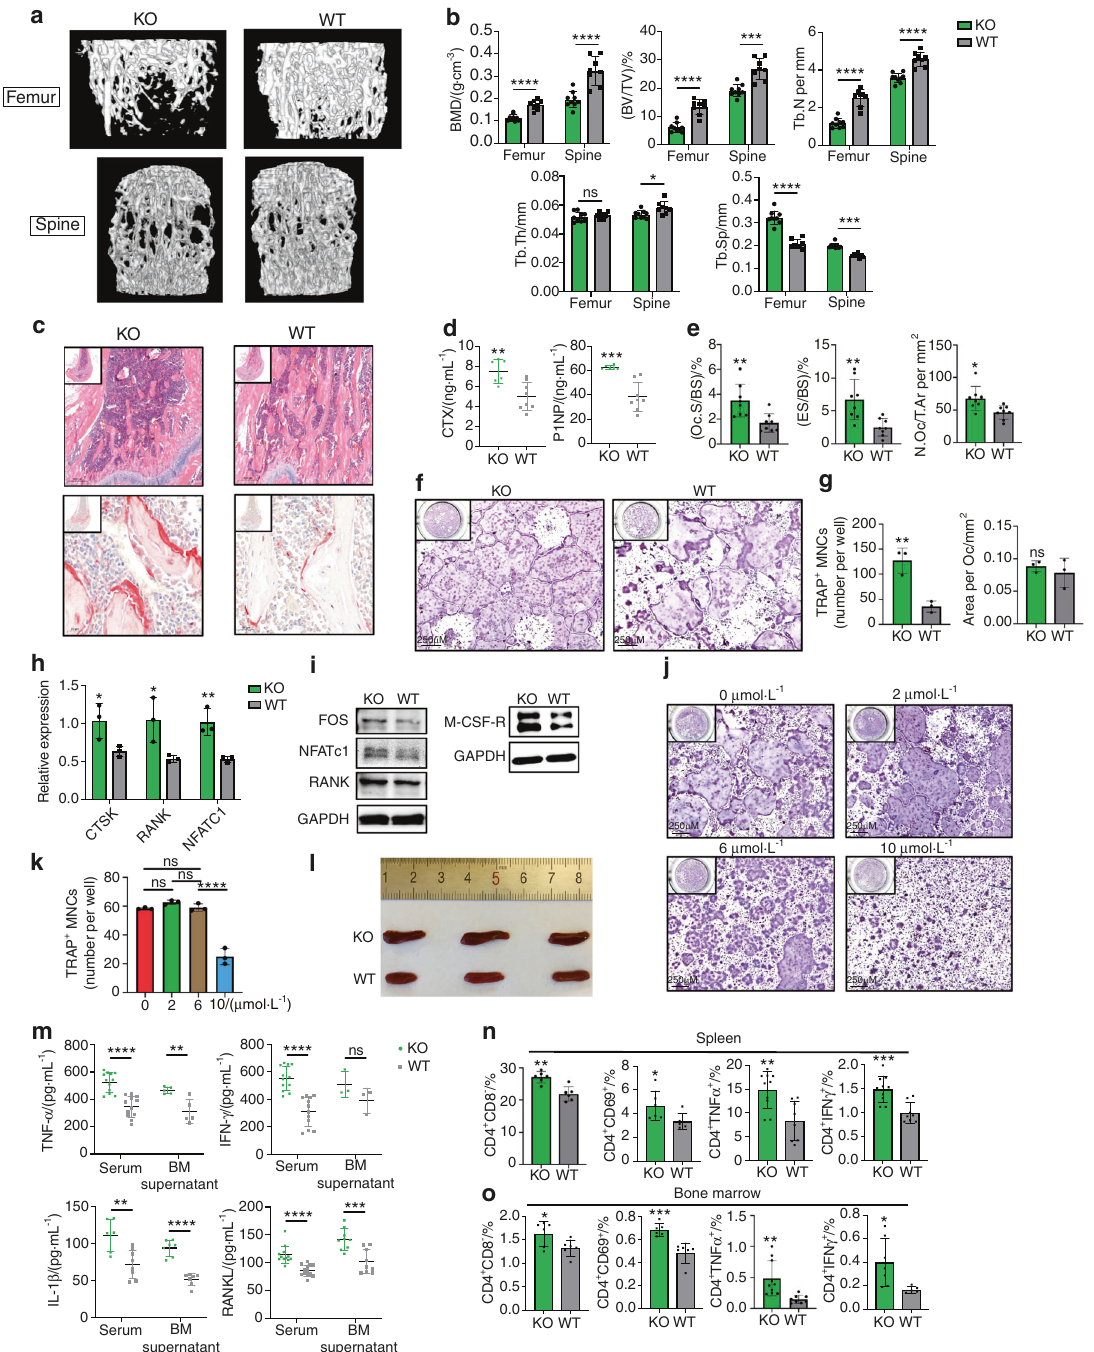
Fig. 1 TLR9 − / − mice had low bone mass, increased osteoclastogenesis and systemic in fl ammation. a Representative 3D μ CT images of femurs and L3 vertebrae from TLR9 − / − (KO) and wildtype (WT) mice. b Trabecular bone microarchitecture of femurs and L3 vertebrae showing bone mineral density (BMD), bone volume per tissue volume (BV/TV), number of trabeculae (Tb. N), trabecular thickness (Tb.Th) and trabecular separation (Tb.Sp). KO, n = 8; WT, n = 9. c Representative HE (upper panels) and TRAP (lower panels) stained images of distal femurs from each group. d Circulating CTX and P1NP levels. KO, n = 6; WT, n = 8. e Histomorphometric analysis of bone resorption indices. n = 8 per group. f – h In vitro osteoclastogenesis assay. f TRAP-stained osteoclast like cells (OCLs). g Quanti fi cation of number and area of TRAP + multinucleated OCLs. h qPCR analysis of osteoclast signature genes ’ expression at the end of assay. i Western blots showing expression of the indicated molecules in early osteoclast precursors. j – k In vitro osteoclastogenesis of wildtype BMNCs in the presence of TLR9 antagonist. j TRAP-stained OCLs. k Quanti fi cation of OCL numbers. l Spleens from 8-week-old male TLR9 − / − and wildtype mice. m Levels of TNF α , IFN γ , IL1 β , and RANKL in serum and bone marrow supernatants. n = 3 to 13 per group. n Splenic T cell populations analyzed by fl ow